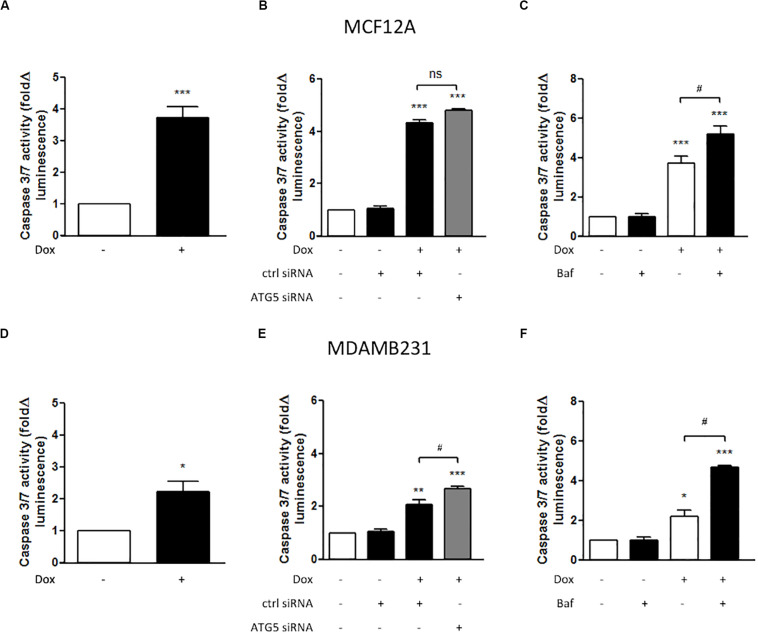
Caspase 3/7 activity in MCF12A and MDAMB231 cells following Dox treatment and autophagy inhibition. Caspase 3/7 activity in MCF12A cells following treatment with Dox alone (A), in combination with ATG5 siRNA-mediated autophagy inhibition (B), and in combination with Baf-mediated autophagy inhibition (C). Caspase 3/7 activity in MDAMB231 cells following treatment with Dox alone (D), in combination with ATG5 siRNA-mediated autophagy inhibition (E), and in combination with Baf-mediated autophagy inhibition (F). Results represent fold change in luminescence in cultures incubated with Dox vs. untreated cells. Images were obtained using a 10× objective with each value representing the mean ± SEM of at least three independent determinations. *p < 0.05; **p < 0.01; ***p < 0.001; #p < 0.05, ns, no significance.